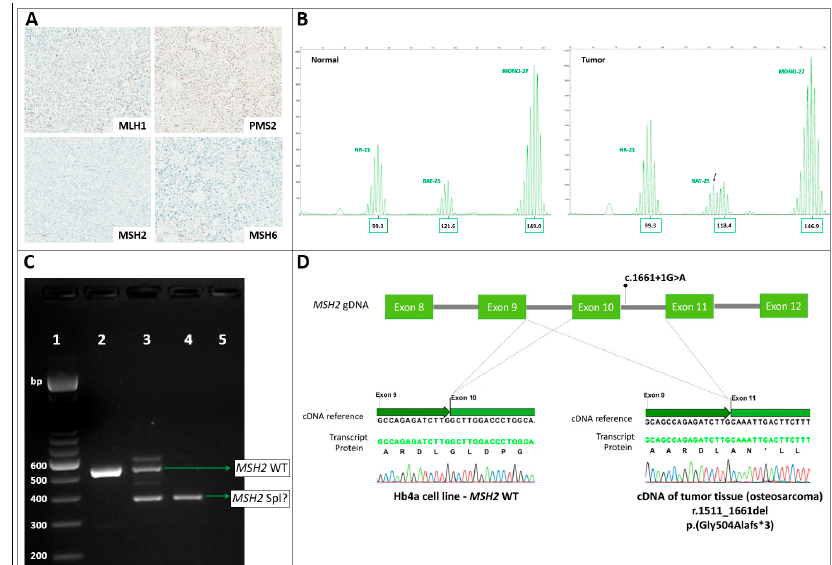
Figure 1. Molecular characterization of the patient SLS1. ( A ) IHC results for the four MMR proteins in the osteosarcoma, showing the nuclear retained positive expression of MLH1 and PMS2 and the loss of expression of MSH2 and MSH6. ( B ) Results of MSI analysis by capillary electrophoresis. The base pair sizes of the major alleles are shown below each marker. For the BAT-25 marker, a new allele (arrow) is evident in the tumor tissue. NR-21 is stable and MONO-27 shows subtle changes of 2 bp in the tumor tissue, indicated by the changes in the heights of the main peaks and the stutter patterns. BAT-26 and NR-24 also exhibited subtle instability (data not shown). ( C ) RT-PCR products amplified from exons 8–12 of the MSH2 transcript, demonstrated on 2% agarose gel; (1) ladder (100 bp); (2) positive control (HB4a cell line) showing the wildtype MSH2 transcript (532 bp); (3) adjacent normal tissue from SLS1 showing the wild-type transcript (532 bp) and an aberrant transcript (400 bp); (4) osteosarcoma tissue from SLS1 showing only the aberrant transcript (400 bp); (5) negative control. ( D ) Sanger sequencing of RT-PCR products from the control cell line and the patient osteosarcoma’s tissue revealed the skipping of MSH2 exon 10 in the aberrant transcript identified in SLS1 tissues.